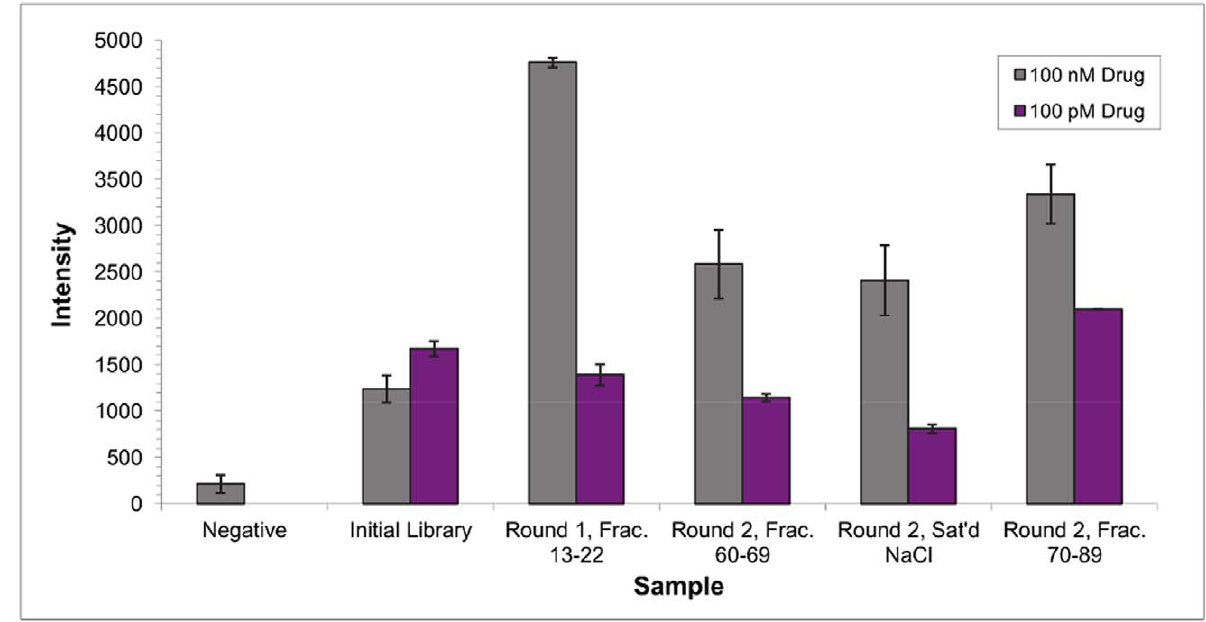
Figure 2. AlphaScreen analysis of selection pools.